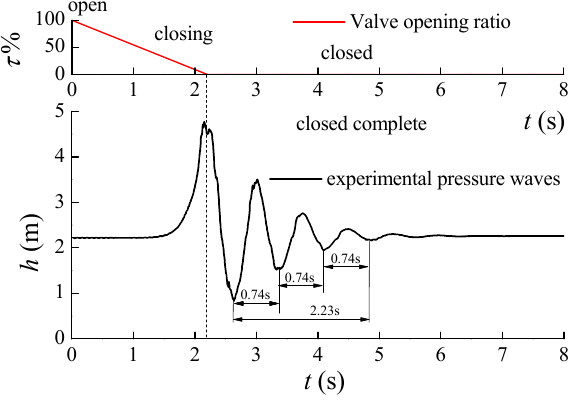
Figure 6. Experimental water hammer progress.